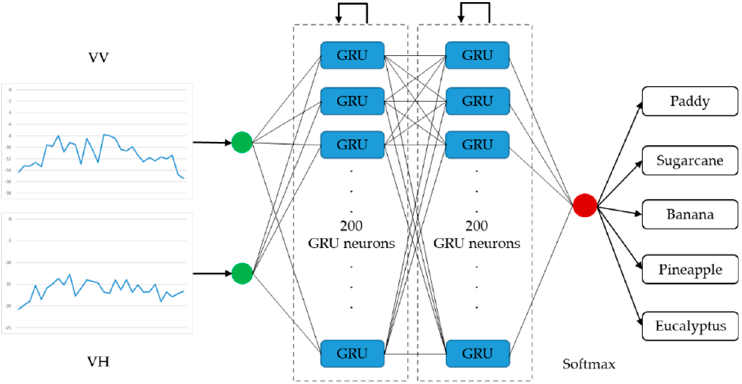
Figure 8. Architecture of the optimal gated recurrent unit recurrent neural network (many-to-one).